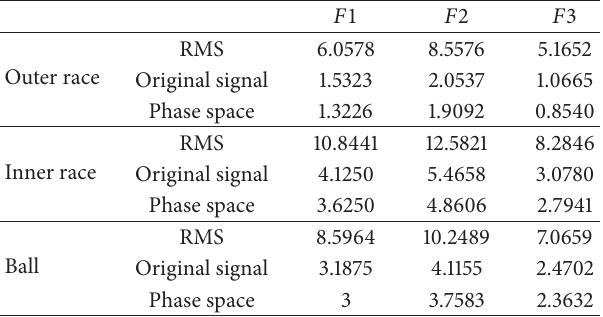
Table 3: Comparison of RUL